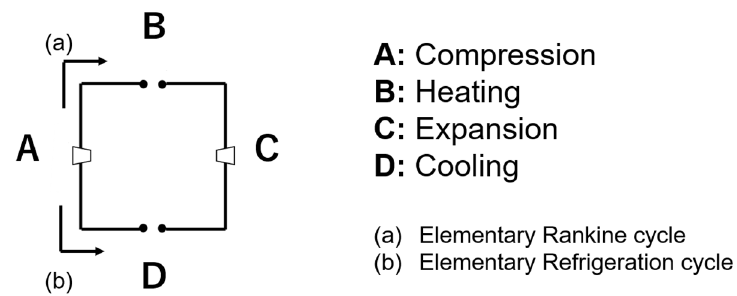
Figure 1. Basic configuration of elementary thermodynamic cycle.